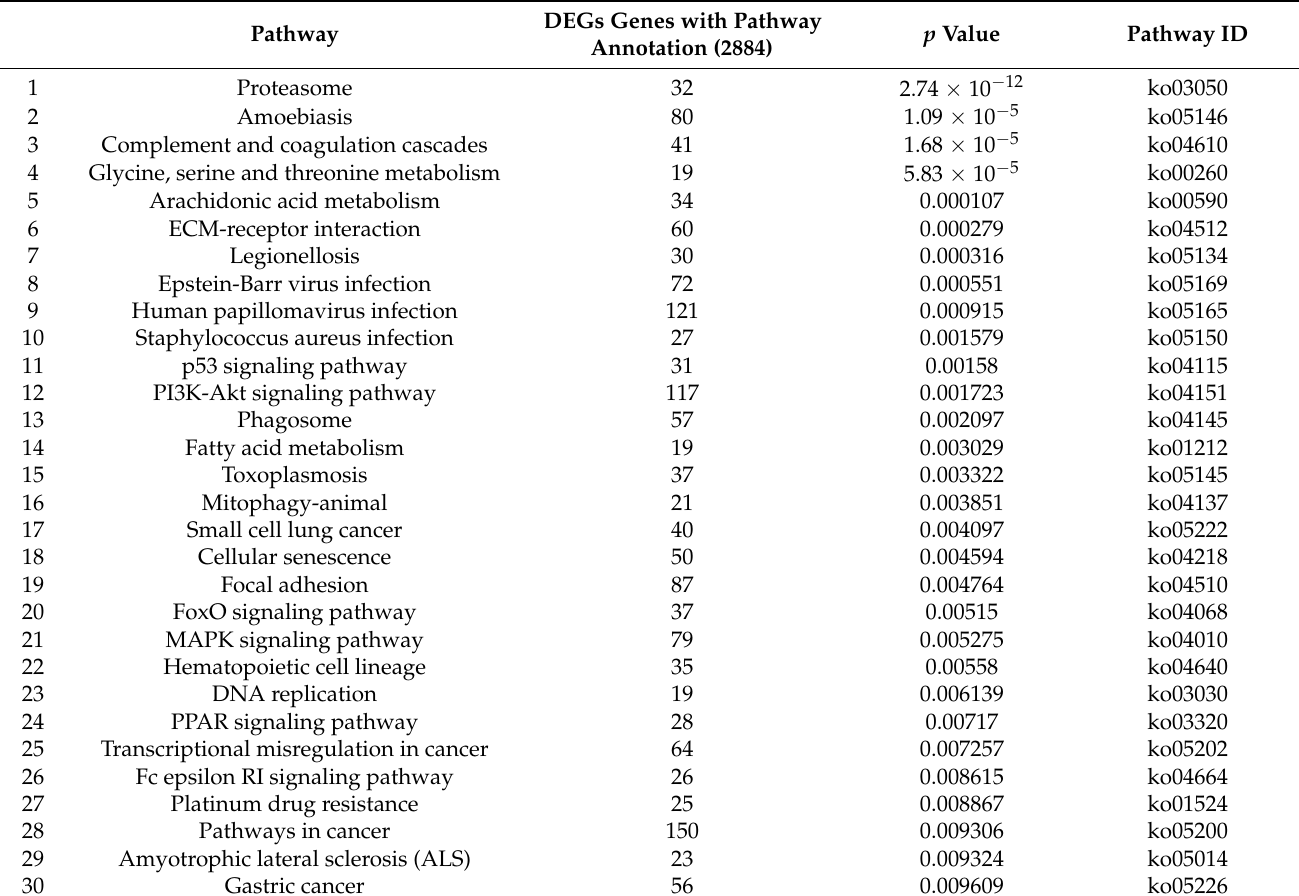
Table 3. Significantly enriched KEGG pathways in RNA-Seq analysis.